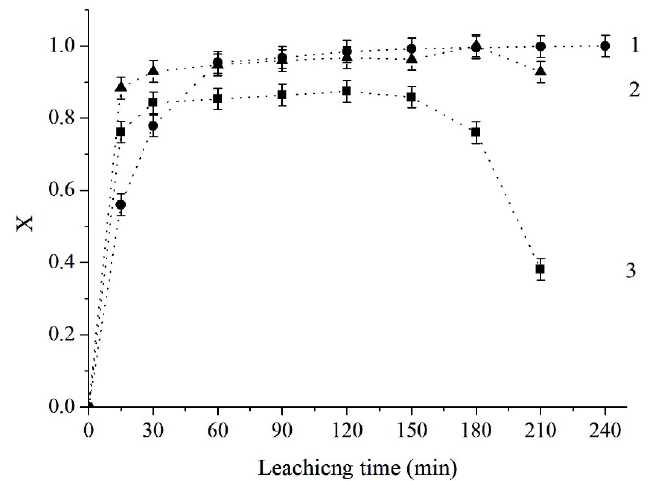
Figure 13. The kinetics of the leaching of ilmenite concentrate during processing in H 2 SO 4 (85 wt%) at temperatures of 180 ° С (1) 190 ° С (2) and 200 ° С (3).